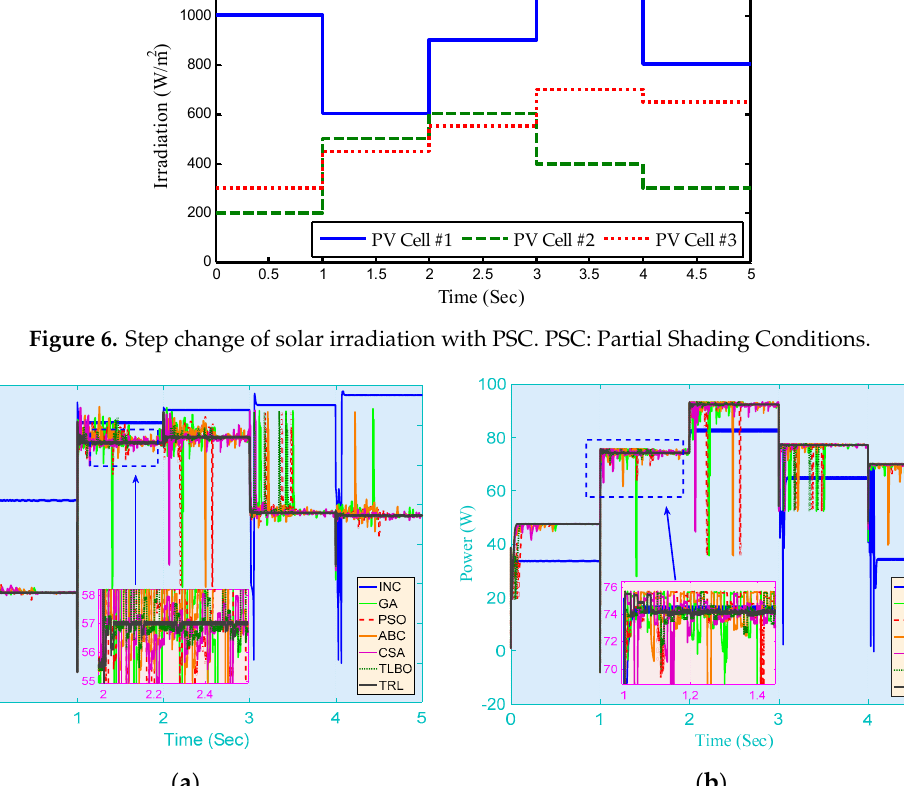
Figure 7. PV system responses of seven methods obtained on the step change in solar irradiation with constant temperature. ( a ) Voltage; ( b ) Power.